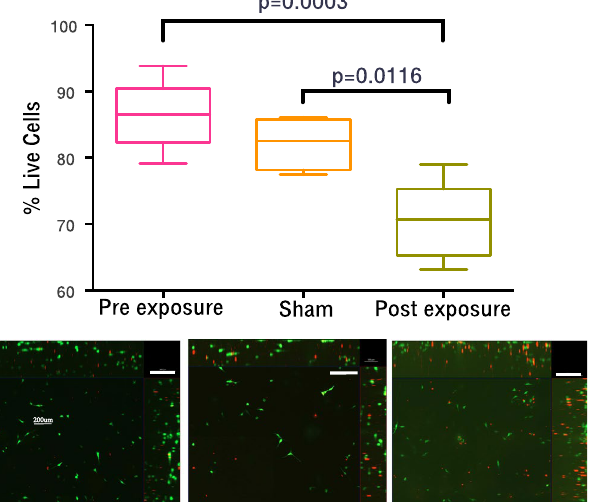
Figure 6. Comparison of the % of live cells in collagen hydrogels with 50,000 HDF cells/ml. Statistically significant differences are shown between the pre and post exposure (p = 0.0003) as well as the sham and post exposure (p = 0.0116). Significance assessed by ANOVA (Tukey’s multiple comparison correction), below the graph are representative images of the 3 conditions scale bars are 200 nm, red fluorescence indicates presence of ethidium homodimer in dead cells, green fluorescence indicates calcien-AM in live cells, N = 6. % cell death calculated by manual counting using formular % Live cells = calcien positive cells/(calcien-AM positive cells + ethidium homodimer positive cells).